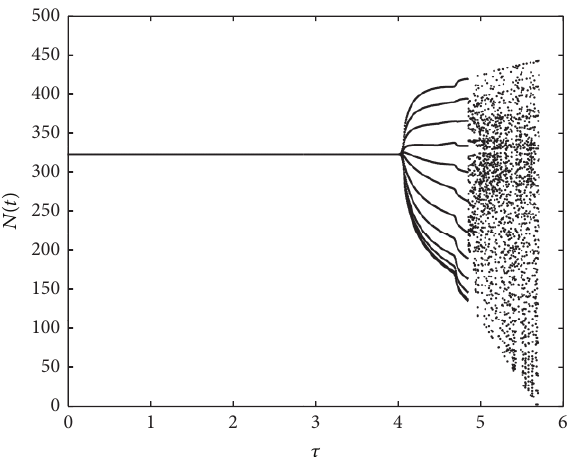
Figure 2: Bifurcation and chaotic properties of the dynamical system of credit risk contagion in the financial market when the time-delay 𝜏 is